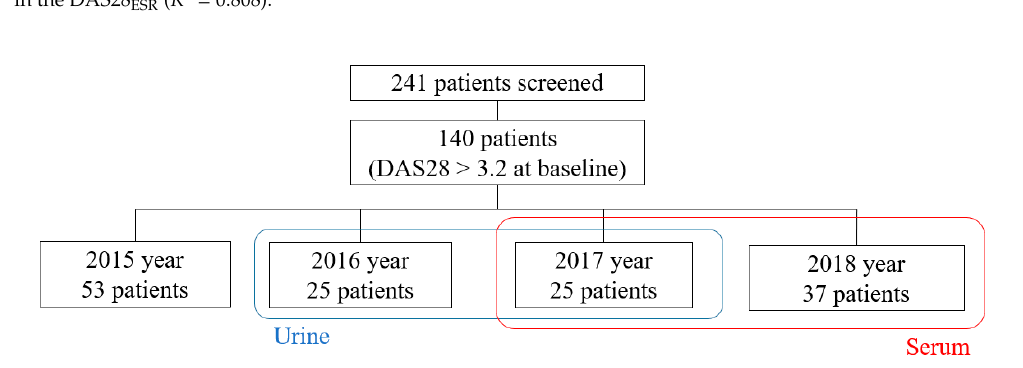
Figure A1. Patients in the CIRAD cohort. Patients were selected from the Center for Integrative